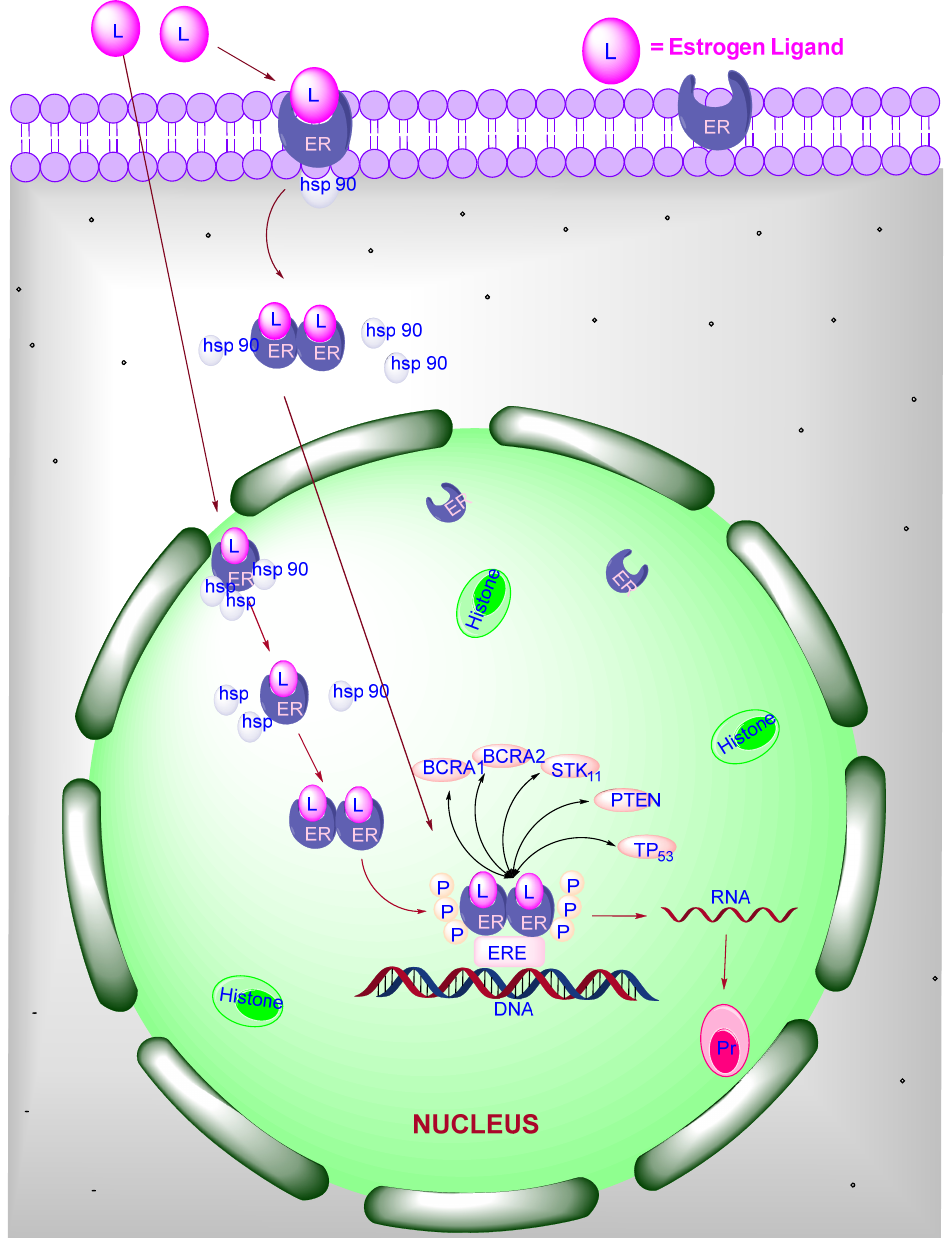
Figure 2. Mechanism of action: when a ligand binds with the ER, which is present on the cell mem- brane or phospholipid layer, the heat shock proteins associated with it are dissociate. Conformational changes take place and further proceeds to dimerization. Due to the receptor’s hydrophobicity, it enters the nucleus and binds with the ERE element on DNA. After that, it activates a variety of genes such as PTEN, STK 11 followed by the transcription process. Subsequently, translational process occurs. On the other hand, ligand (estradiol) directly enters into nucleus because of its hydrophobic nature. Next, the same process is also occurring here.